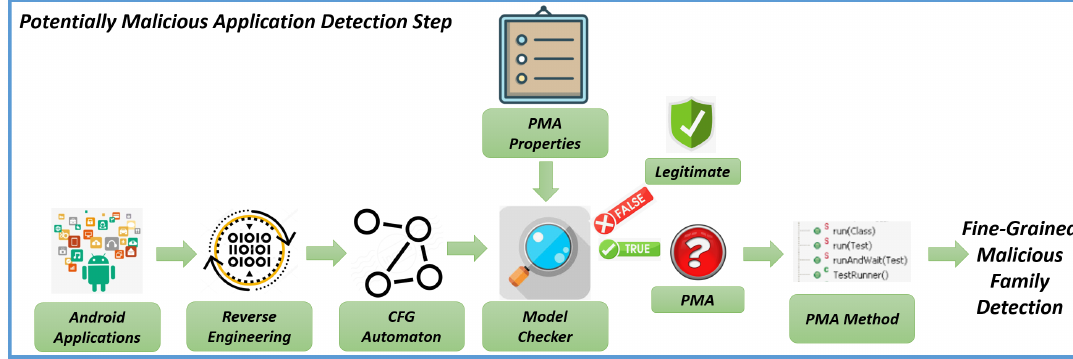
Figure 1. Potentially malicious application detection step.